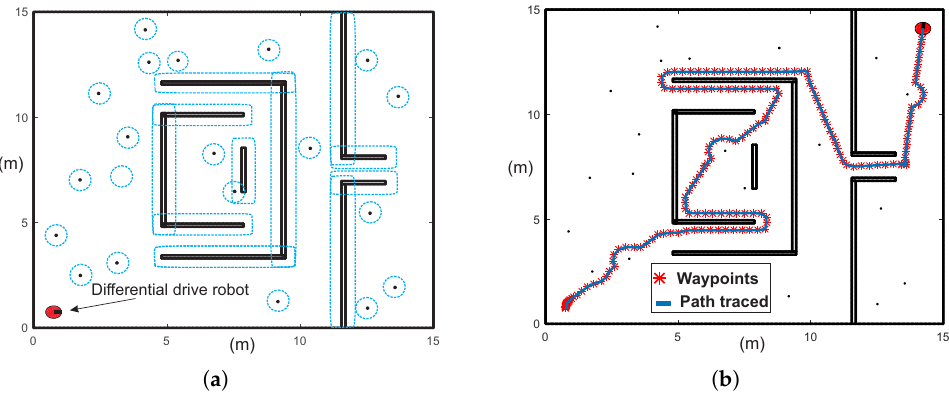
Figure 29. Pure-pursuit path tracking for the solution path of case study 4. ( a ) Floor plan considering dimensions of the robot. ( b ) Path traced by differential drive